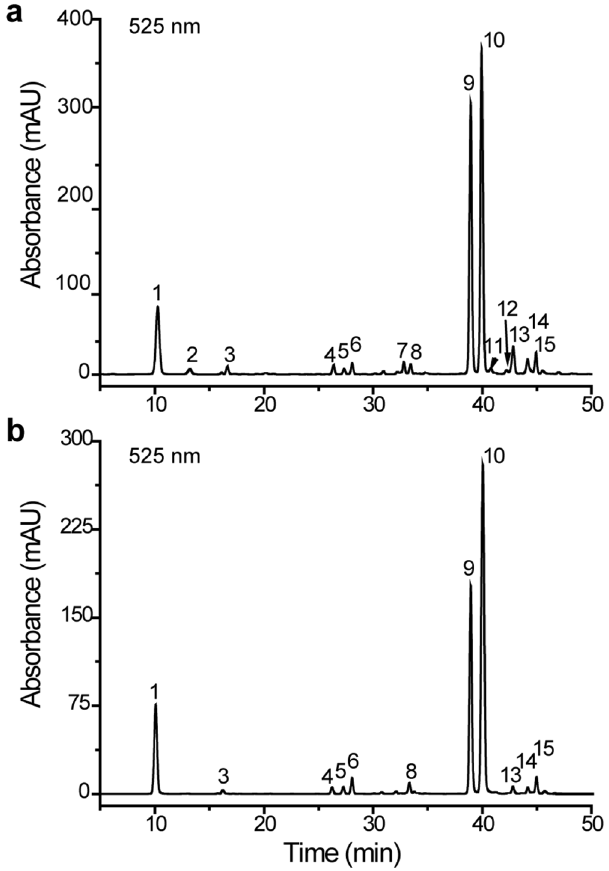
Figure 1. HPLC chromatograms of anthocyanins in fresh-cut red cabbage detected at 520 nm. ( a ) The HPLC profiles of anthocyanins from UV-C treated (3.0 kJ/m 2 ) fresh-cut red cabbage after 8 days of storage. ( b ) The HPLC profiles of anthocyanins in untreated fresh-cut red cabbage. Peak assignments are listed in Table